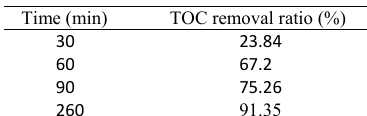
Table1. TOC removal ratio on the miniralization of NBB solution at different reaction time. (pH=3, [catalyst mass] =0.005g,